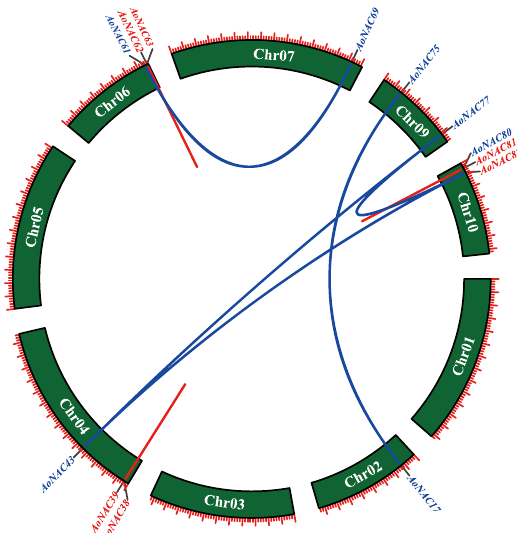
Table 2. Tandem duplication in AoNAC genes and corresponding Ka, Ks, and Ka/Ks values.